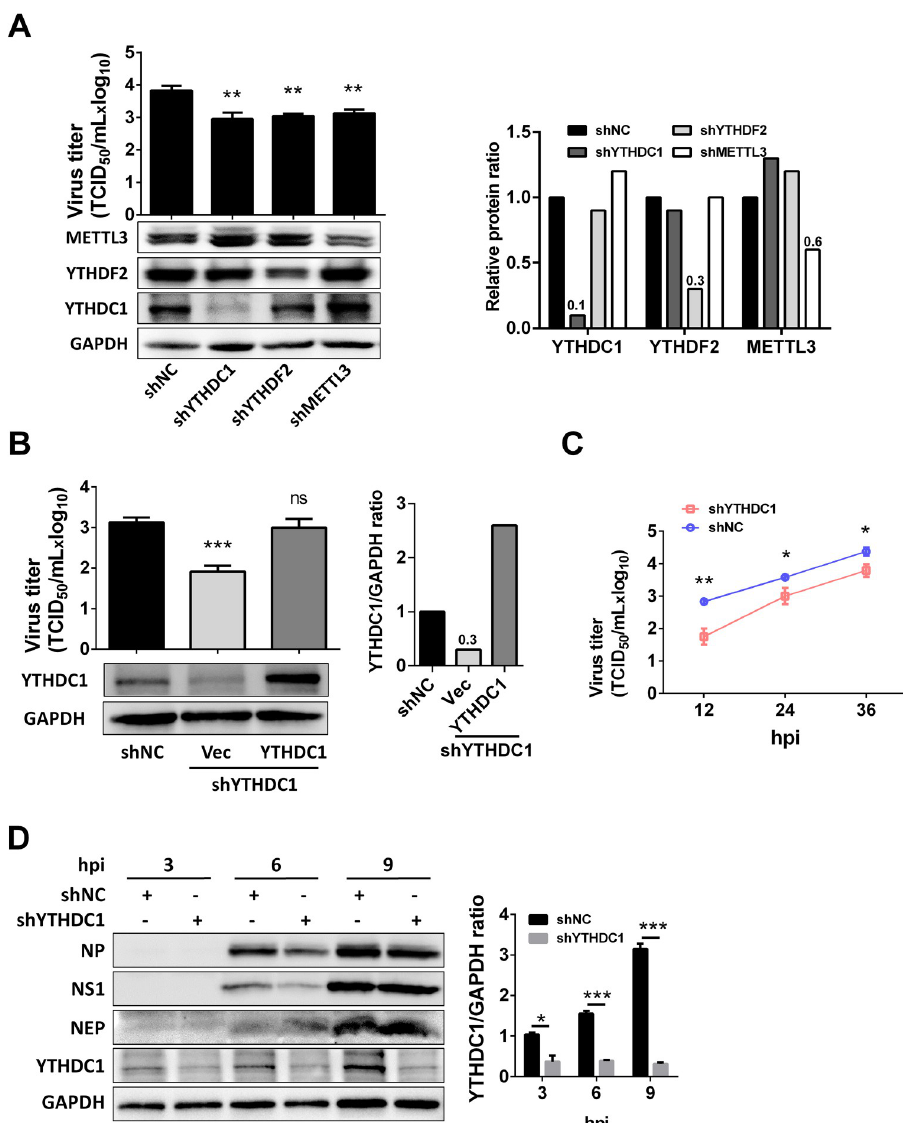
Fig 2. YTHDC1 promotes PR8 virus replication. (A) METTL3, YTHDF2, and YTHDC1 were knocked down in A549 cells by shRNA, and then infected with the PR8 virus. Virus titer and protein expression were detected by TCID 50 and western blotting at 24 hpi (left). Each protein band was quantified by ImageJ and normalized to GAPDH levels (right). Data are presented as the average of three experiments and error bars indicate the standard error of the mean (SEM) (one-way ANOVA; ** , P < 0.01). (B) WT and YTHDC1 knockdown A549 cells were transfected with 0.5 μ g YTHDC1 for 24 hours, vector as a control, and then infected with PR8 virus (MOI = 0.01) for 24 h. Virus titer was detected by TCID 50 assay (left). Each protein band was quantified by ImageJ and normalized to GAPDH levels (right). Data are presented as the average of three experiments and error bars indicate the standard error of the mean (SEM) (Student t-test; ns, not significant; *** , P < 0.001). (C) A549 cells were infected with the PR8 virus at an MOI of 0.01. Cell culture supernatants were collected at 12, 24, and 36 hpi. Virus titers were determined by TCID 50 assay on MDCK cells. Data are presented as the average of three experiments and error bars indicate the standard error of the mean (SEM) (two-way ANOVA test; * P < 0.05, ** , P < 0.01). (D) YTHDC1 knockdown (shYTHDC1) or negative control (shNC) knockdown A549 cells were infected with the PR8 virus at an MOI of 5. Cell lysates were subjected to western blotting analysis at 3, 6, and 9 hpi. GAPDH was used as a loading control. Each protein band was quantified by ImageJ and normalized to GAPDH levels. The YTHDC1/GADPH protein ratio was calculated. Data are presented as the average of three experiments and error bars indicate the standard error of the mean (SEM) (one-way ANOVA; ns, not significant; * , P < 0.05; *** , P <